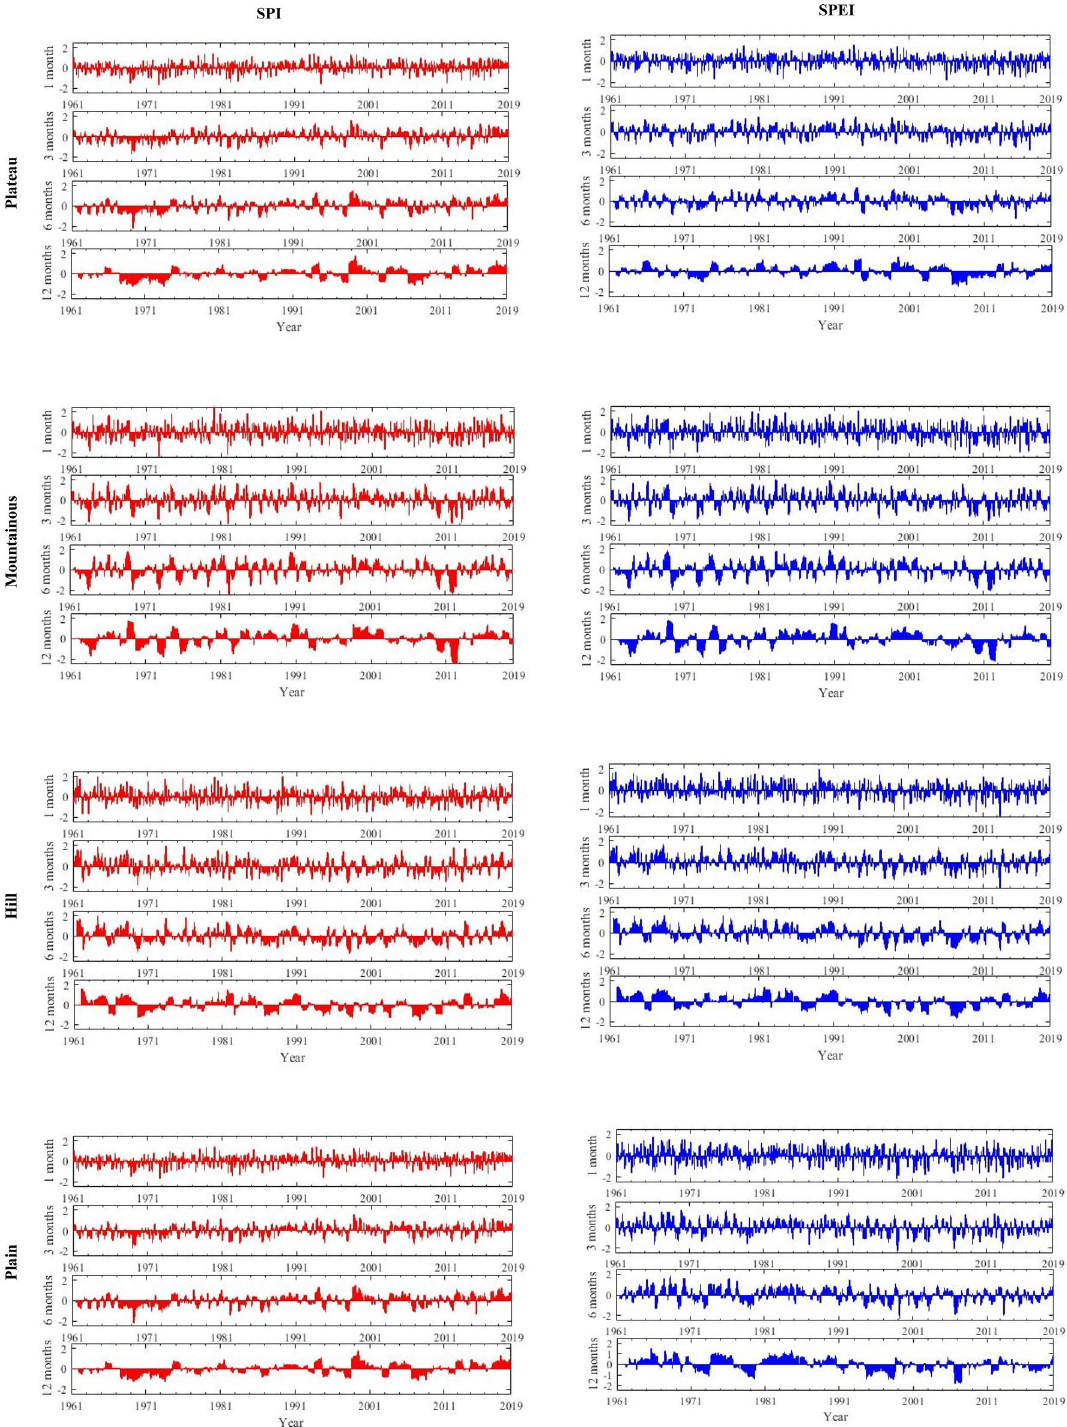
Figure 2. The SPI and SPEI at different timescales for different geomorphologic types (plateaus, mountains, hills and plains) in Sichuan Province. (The figure was generated by MATLAB 2016 software, https ://www.mathw orks.com/produ cts/matla